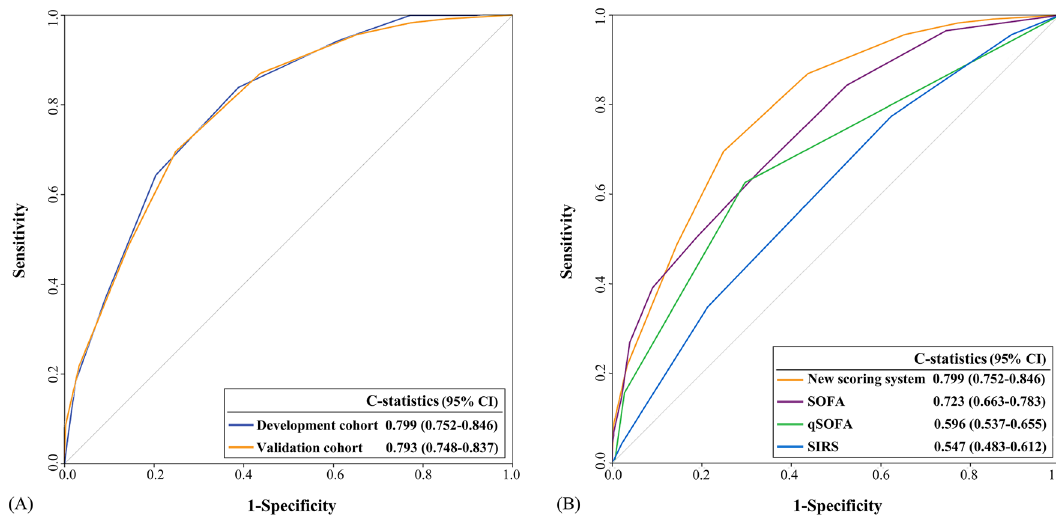
Figure 2. The C-statistics of the new scoring system in the development cohort and the validation cohort (A) , and comparison of the new scoring system with SOFA, qSOFA, and SIRS (B) . The C-statistics for the 30-day mortality of the new scoring system was 0.799 (95% confidence interval [CI]; 0.752–0.846) in the development cohort and 0.793 (95% CI; 0.747–0.838) in the validation cohort (A) . The C-statistics of the new scoring system was significantly higher than those for SOFA [0.723 (95% CI: 0.663–0.783, P = 0.018)], qSOFA [0.596 (95% CI: 0.537–0.655, P < 0.001)], and SIRS [0.547 (95% CI: 0.483–0.612, P < 0.001)]. CI confidence intervals,